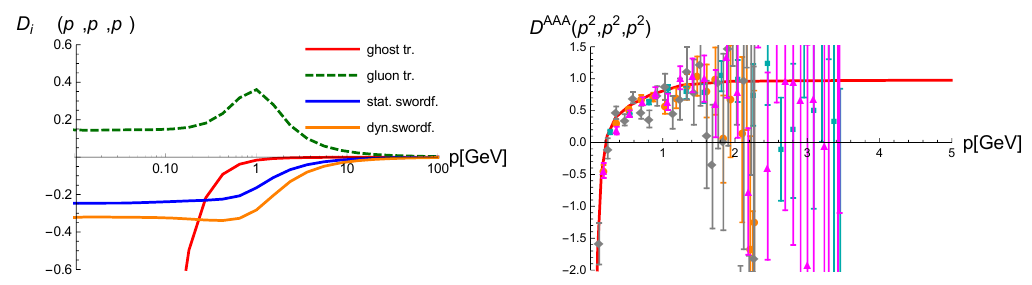
Figure 3. Left: Contributions of single diagrams to the three-gluon vertex. Right: Comparison of the result for the three-gluon vertex tree-level dressing function to lattice results